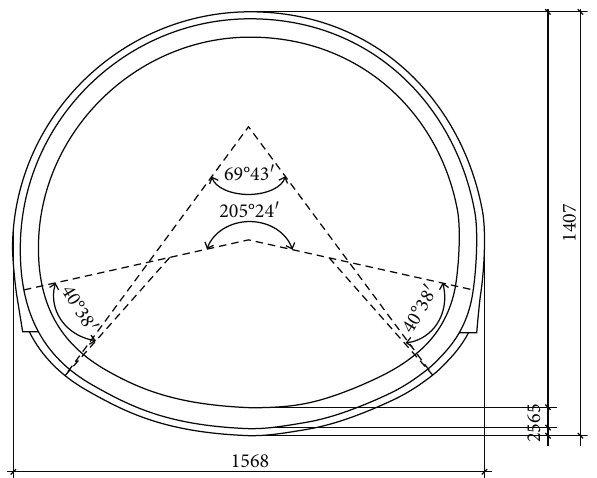
Figure 1: Tunnel support